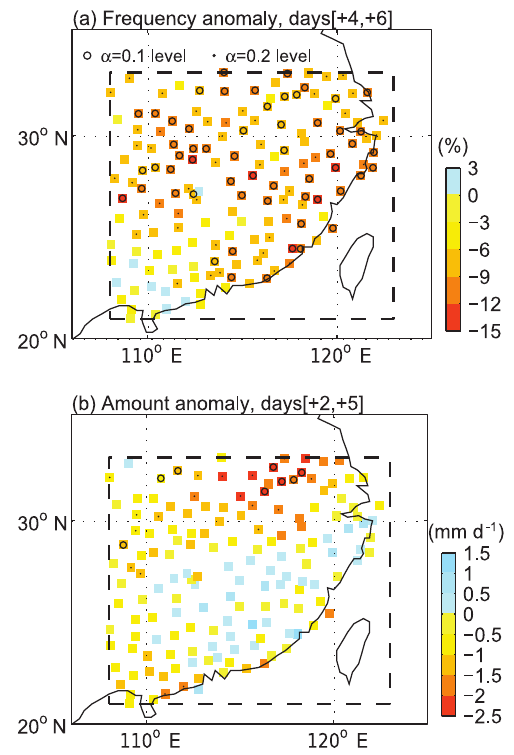
Figure 3. Anomalies of the precipitation frequency (a) and amount (b) . The significance values are estimated using a Monte Carlo approach; stations with circles and dots denote that all days have values significant at the 0.1 and 0.2 levels,